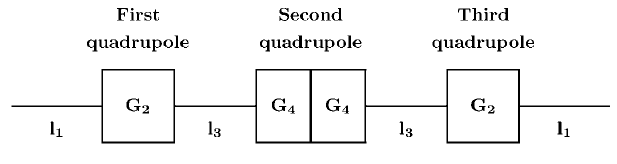
FIG. 7. Schematic of a symmetric